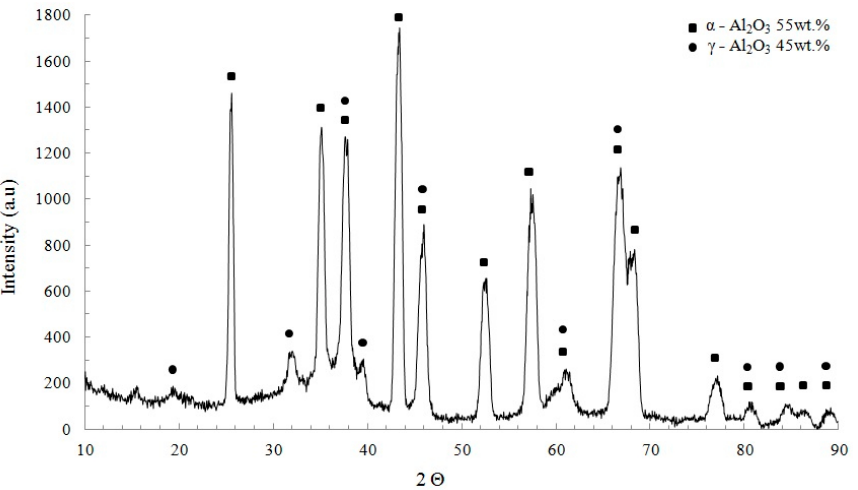
Figure 5. X-ray diffraction pattern of aluminum 1050 alloy surface after PEO treatment.